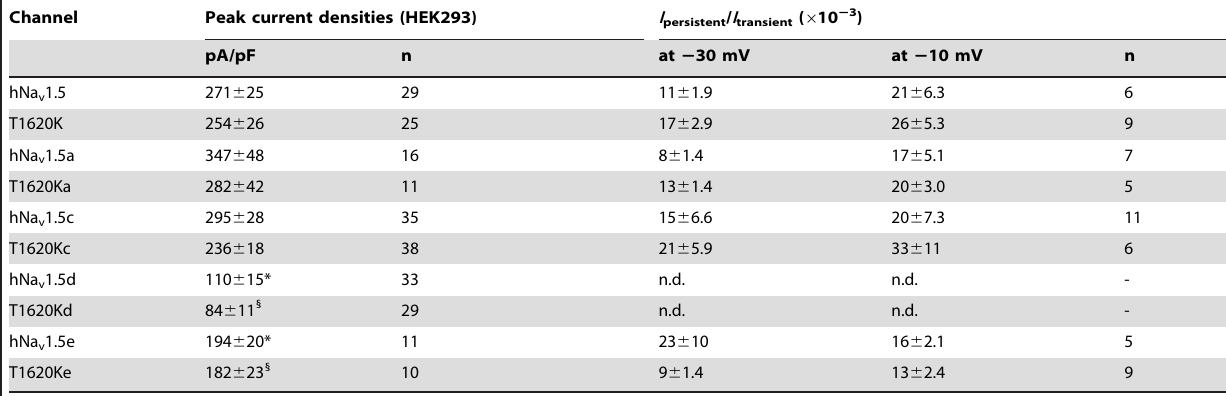
Table 3. Peak current densities and persistent currents.